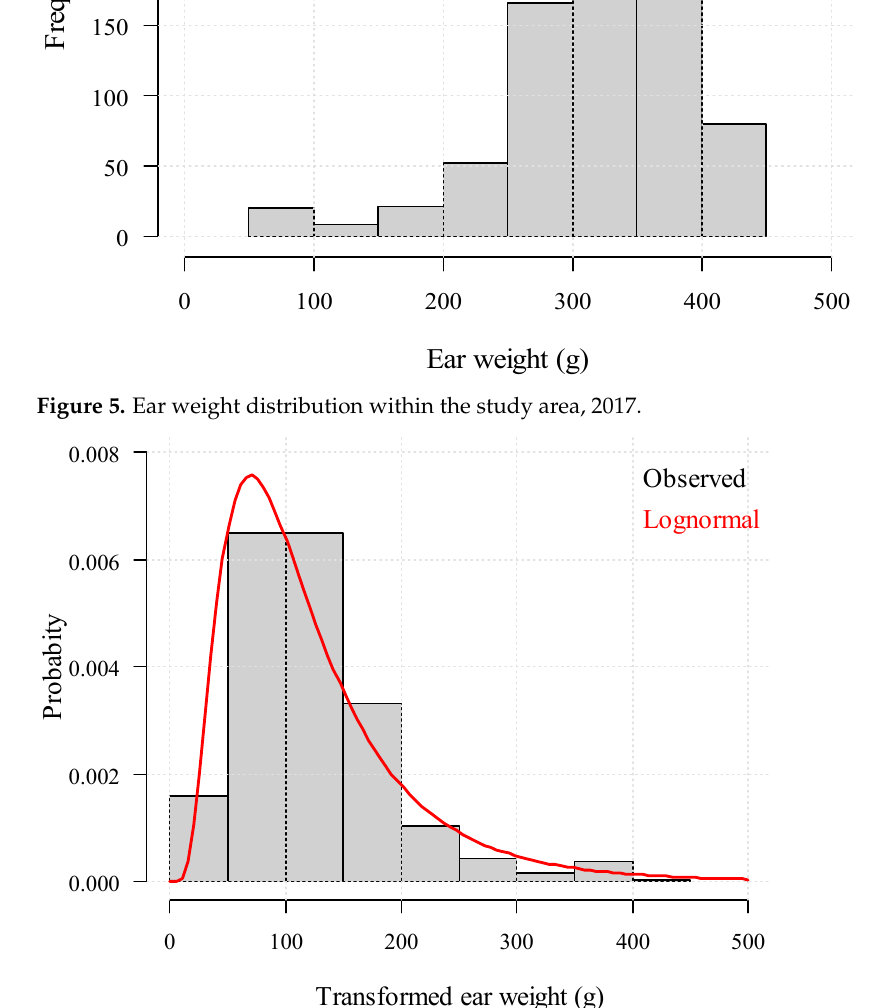
Figure 6. Histogram of the transformed ear weight with a lognormal distribution curve for the study area, 2017.